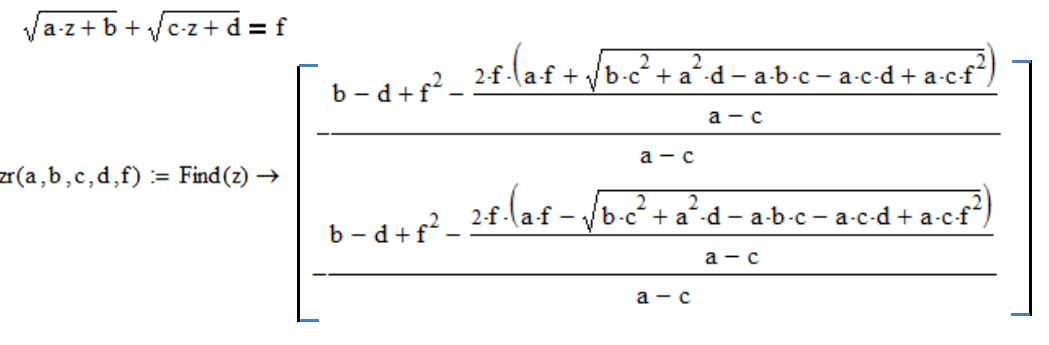
Figure 1. Listing of the Mathcad program for the symbolic solution of Equation (1).